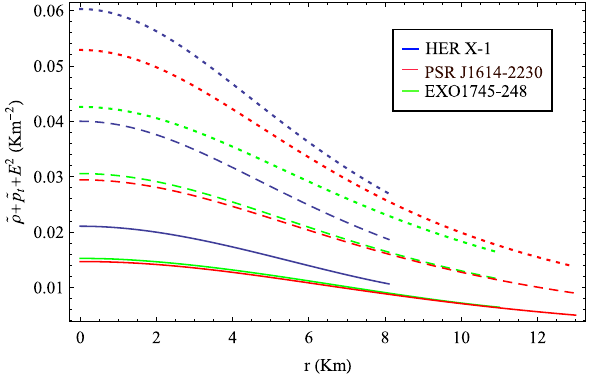
Fig. 13 Radial variation of ˜ ρ − ˜ p r + E 2 for different compact objects as indicated in the figure. Here plots with solid, dashed and dotted lines correspond to D = 4 , 5 and 6 respectively. To obtain the plots we choose (i) α = 0 . 4, γ = 0 . 45 when D = 4; α = 0 . 3, γ = 0 . 25 when D = 5 and α = 0 . 25, γ = 0 . 2 when D = 6 for HER X-1, (ii) α = 0 . 4, γ = 0 . 5 when D = 4; α = 0 . 3, γ = 0 . 25 when D = 5 and α = 0 . 2, γ = 0 . 15 when D = 6 for PSR J1614-2230, (iii) α = 0 . 4, γ = 0 . 5 when D = 4; α = 0 . 3, γ = 0 . 2 when D = 5 and α = 0 . 2, γ = 0 . 25 when D = 6 for